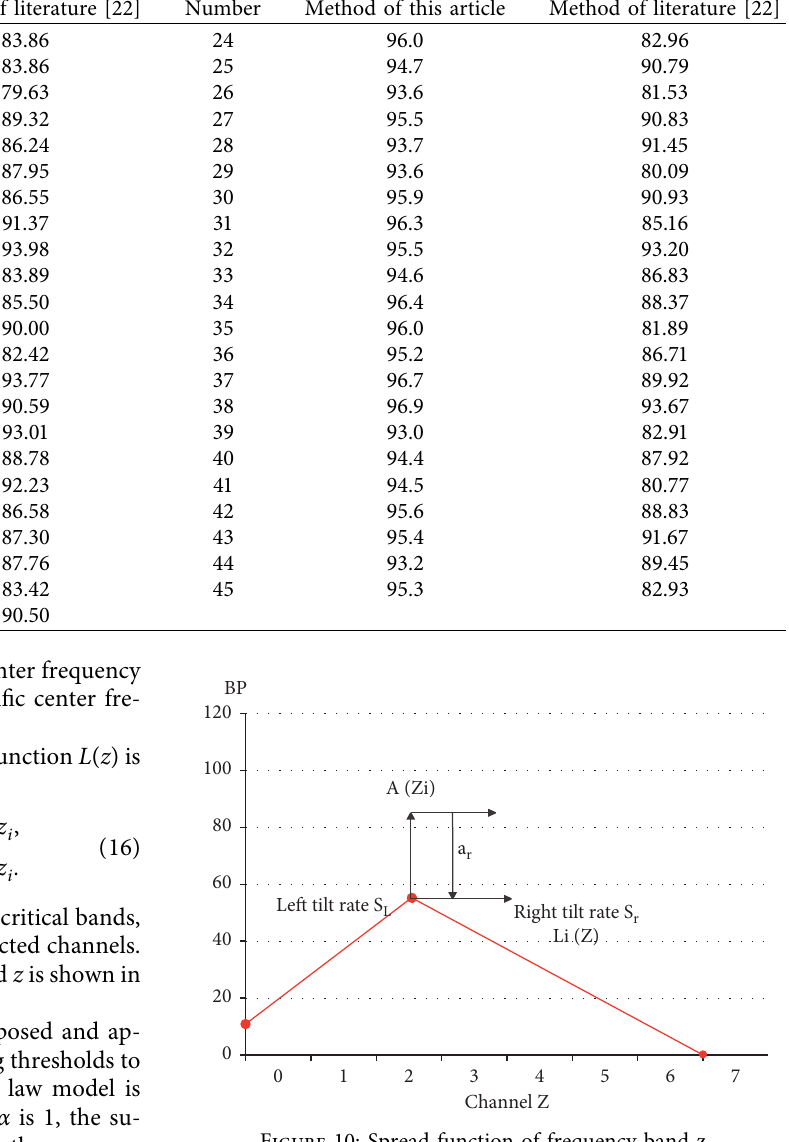
Table 3: English speech recognition